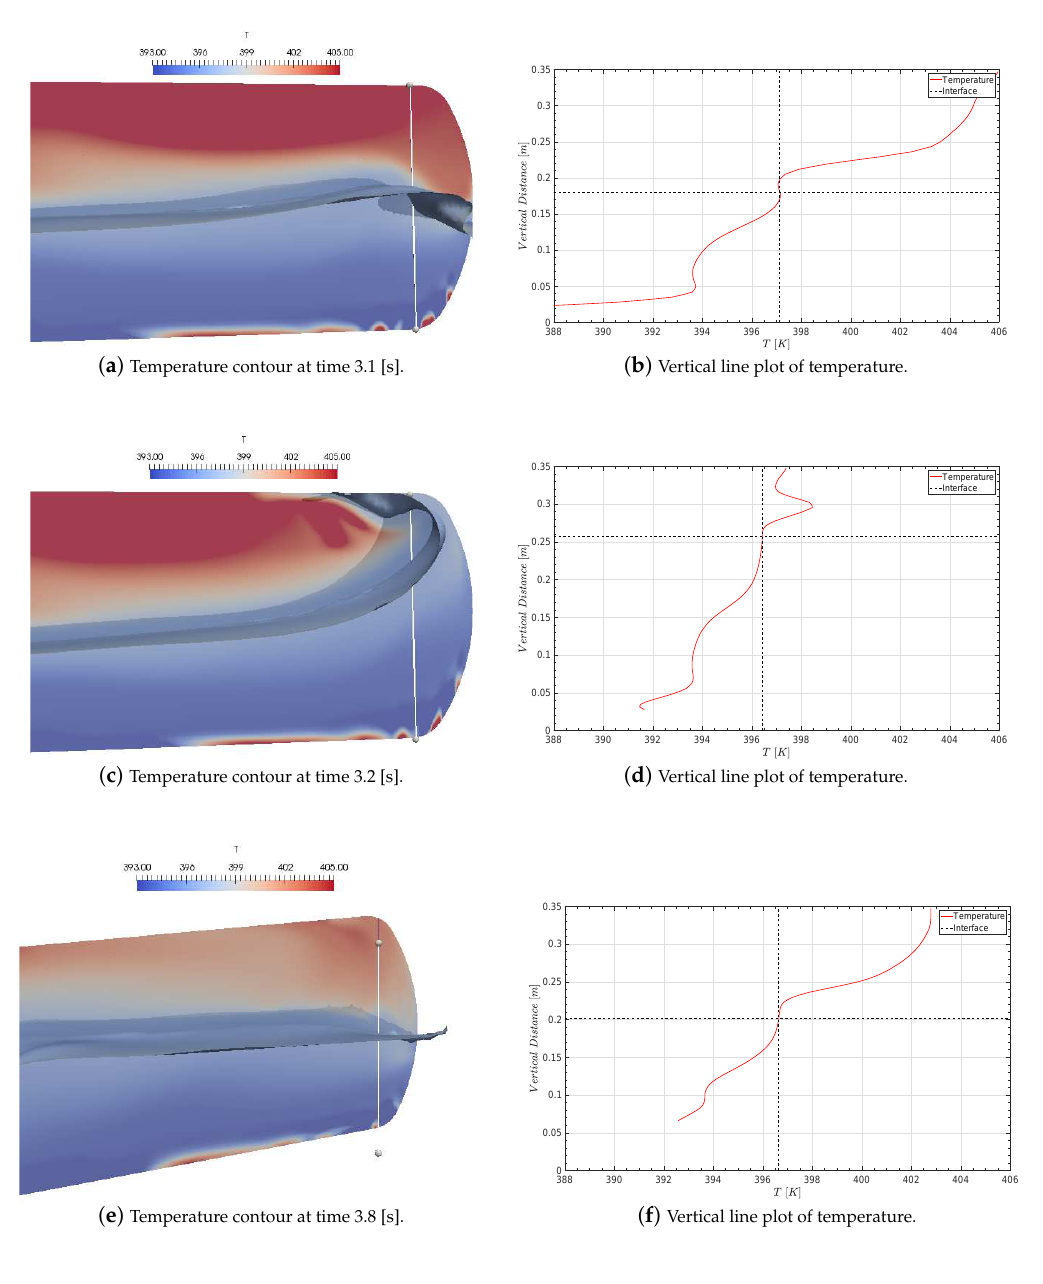
Figure 12. Simulated temperature profile in case number 3. The left column shows temperature contours at different time instants. To the right is the temperature profile along the white marked line inside the tank. The series shows the occurrence of a jet, where, in the last picture, the wave has left and is heading towards the opposite side of the tank. The gas temperature has dropped by 4 ◦ C during these few